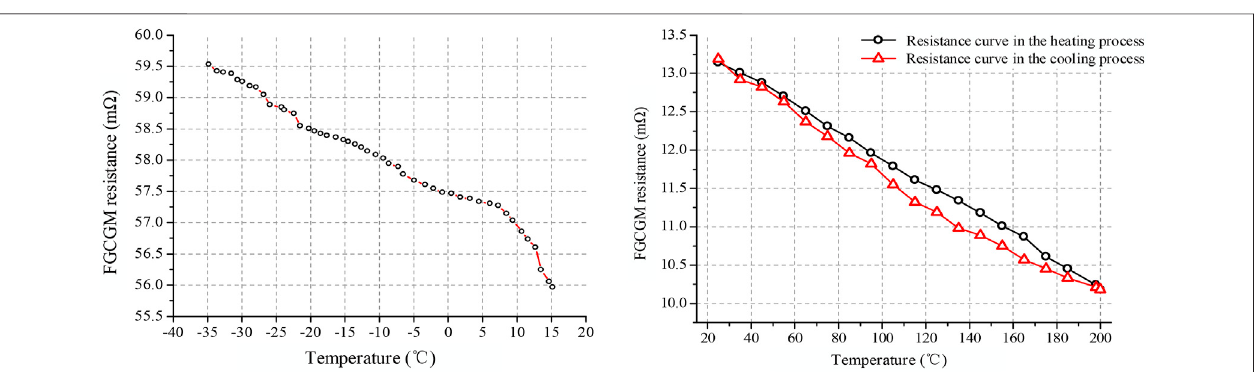
FIGURE 12 | Resistance of FGCGM ontology in low and high-temperature tolerance